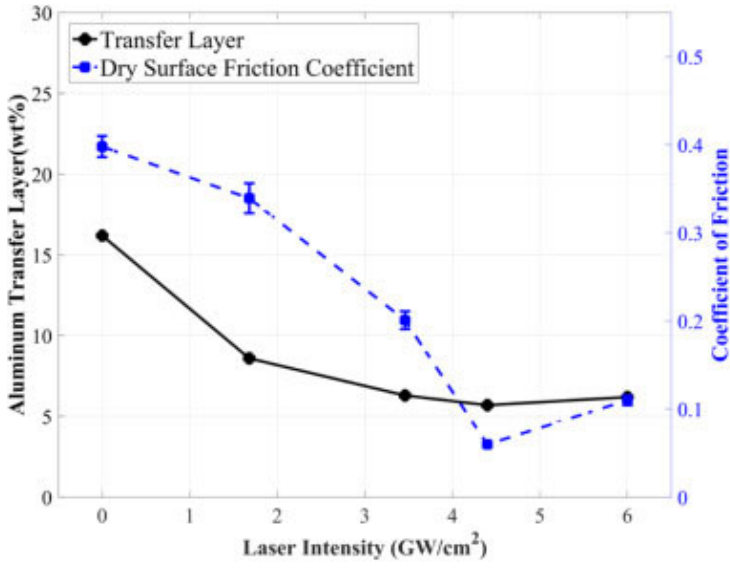
Figure 8. LSP influence on COF and transfer layer [73].